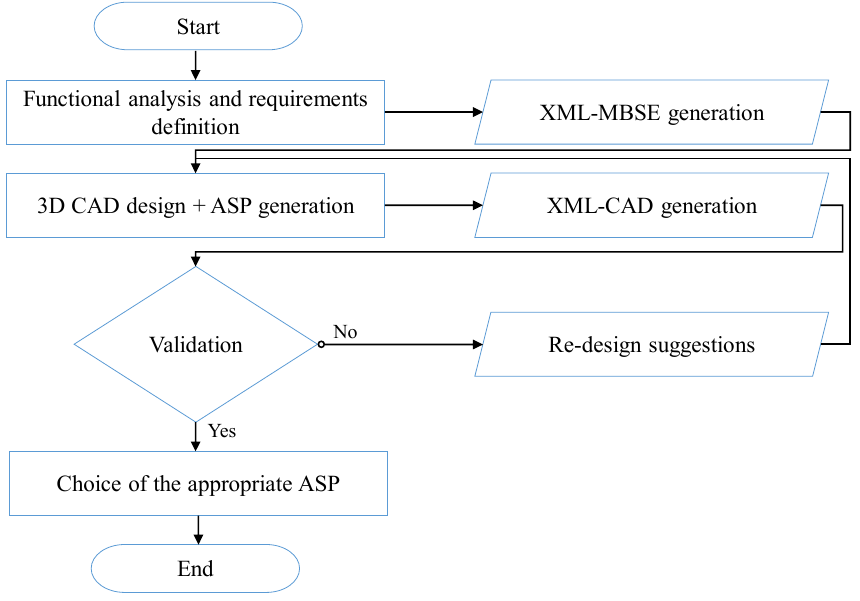
Figure 1. Flowchart of proposed methodology .